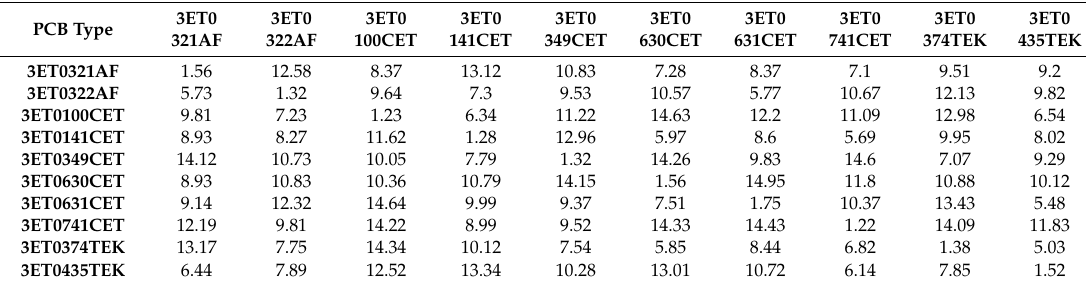
Table 8. Setup times (s) between